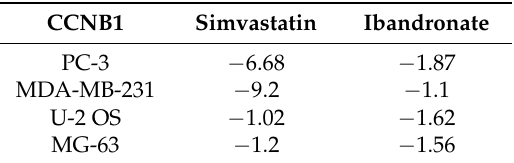
Table 3. Fold downregulation of cyclin B1 CCNB1 .